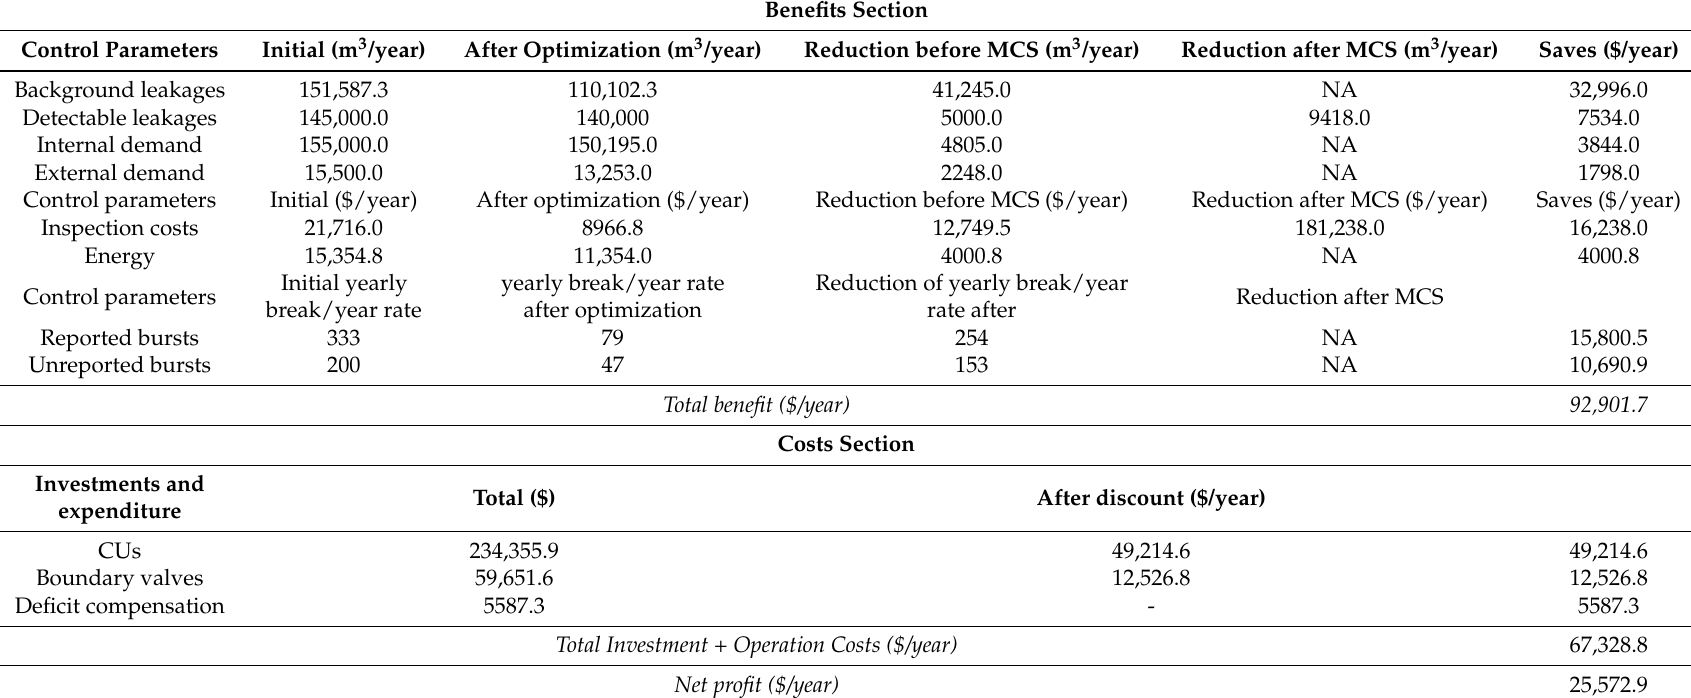
Table 4. Costs/benefits balance obtained for the example